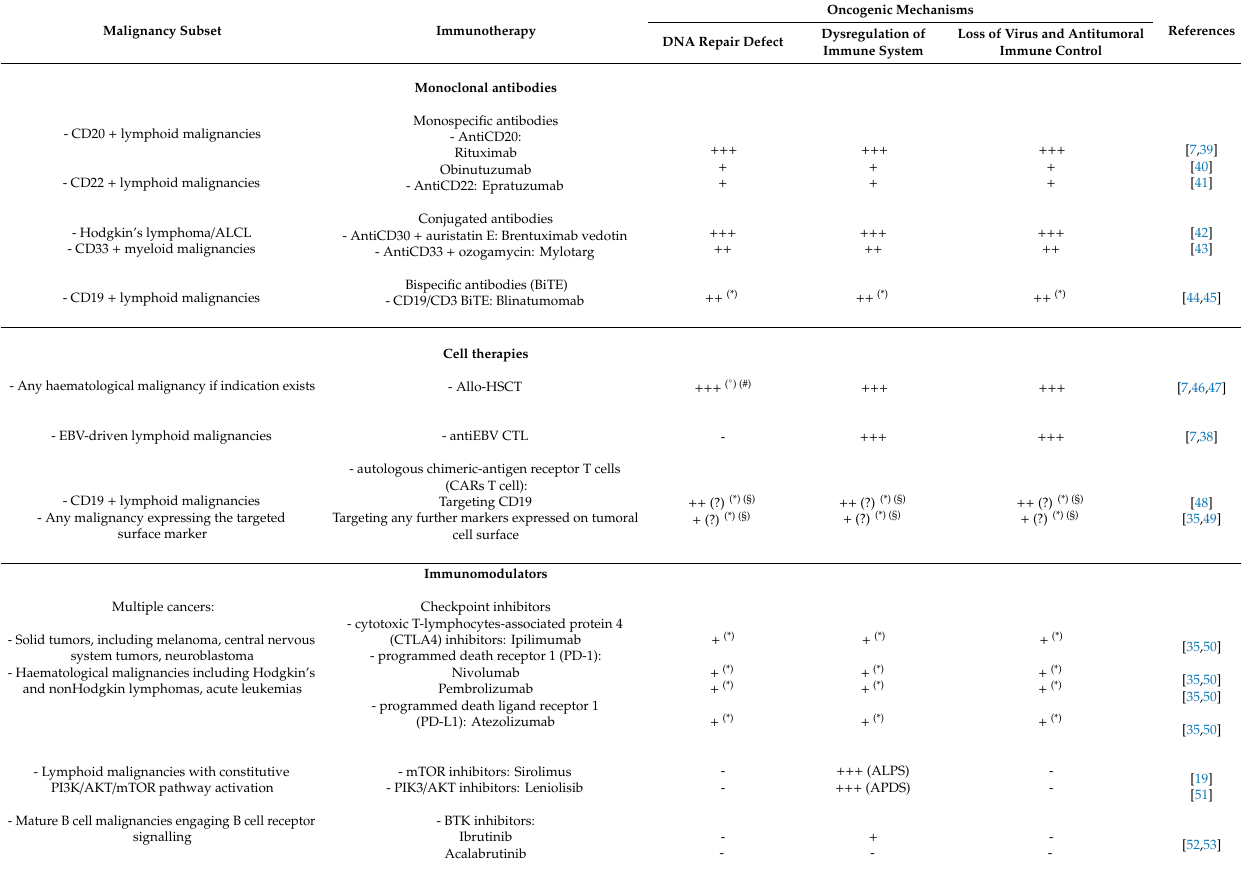
Table 2. Summarises possibilities of immunotherapy in cancer associated with